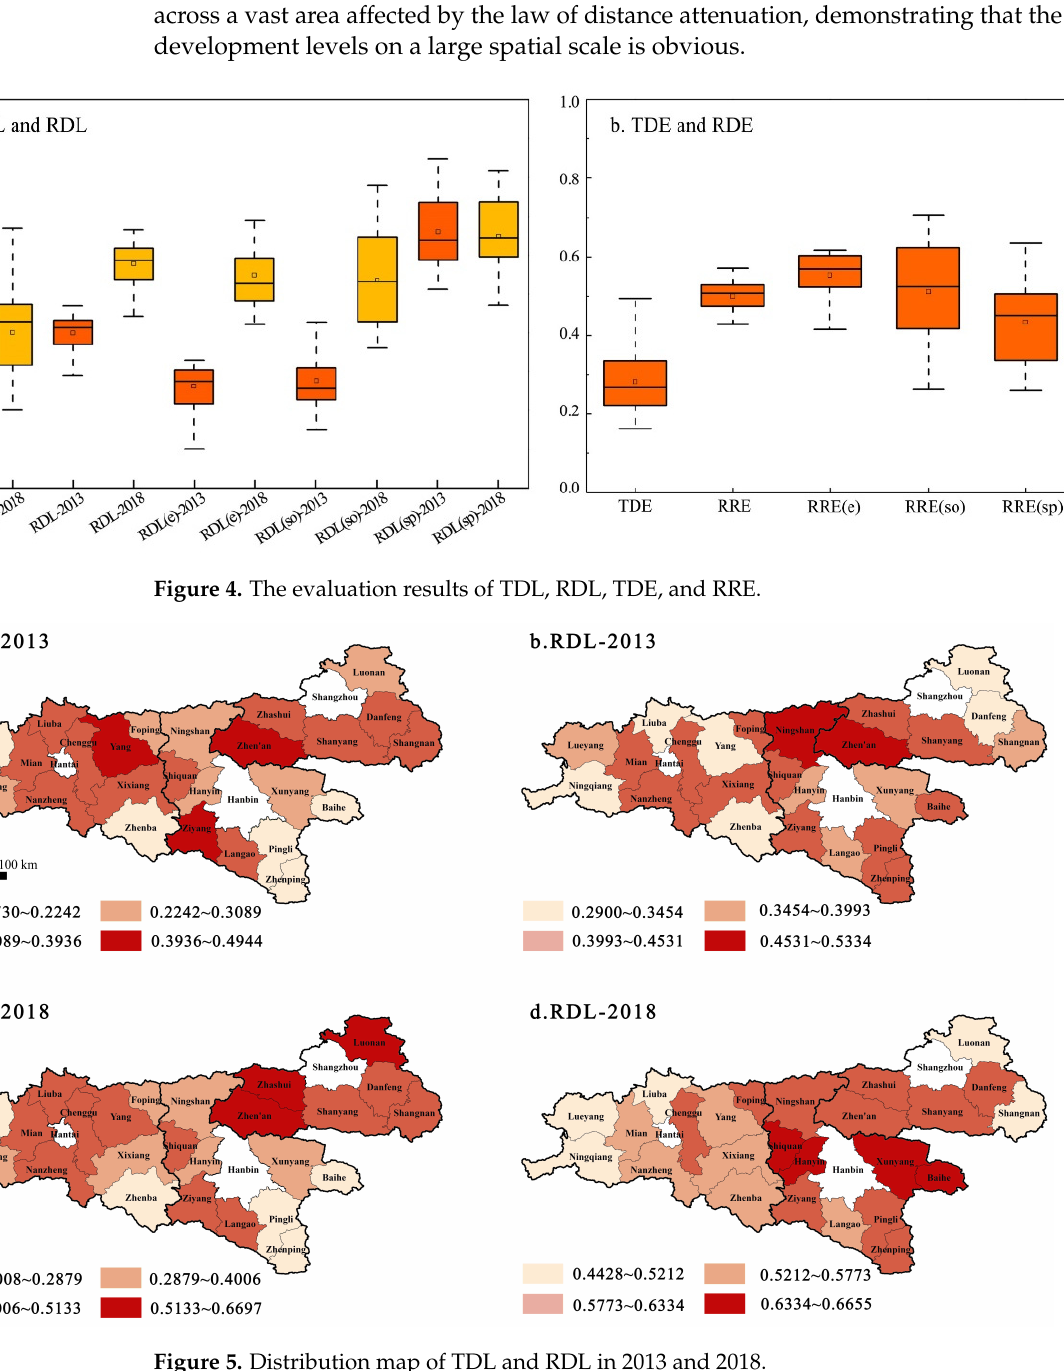
Figure 5. Distribution map of TDL and RDL in 2013 and